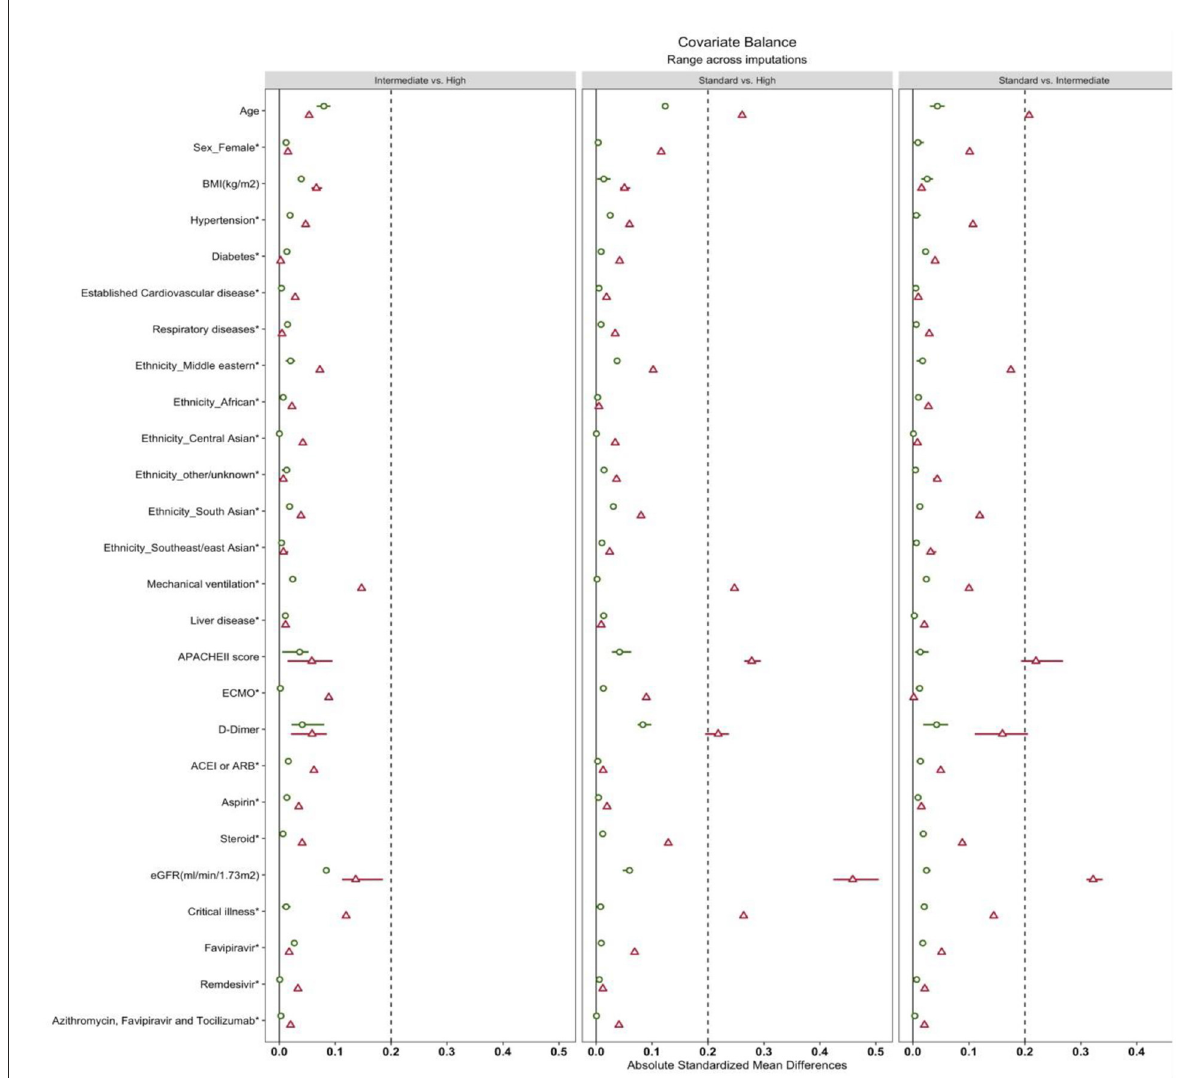
FIGURE2 Love plots of covariate balance. BMI, body mass index. Established cardiovascular disease was defined as a documented history of stable angina, unstable angina, percutaneous coronary intervention (PCI), coronary artery bypass graft surgery, myocardial infarction (MI), heart failure or cerebrovascular disease included transient ischemic attack (TIA) or stroke. Respiratory disease: asthma or chronic obstructive pulmonary disease (COPD), the Acute Physiology and Chronic Health Evaluation (APACHE II). ECMO, extracorporeal membrane oxygenation; ACEI, angiotensin-converting enzyme inhibitors; ARB, angiotensin receptor blockers; eGFR, estimated Glomerular Filtration